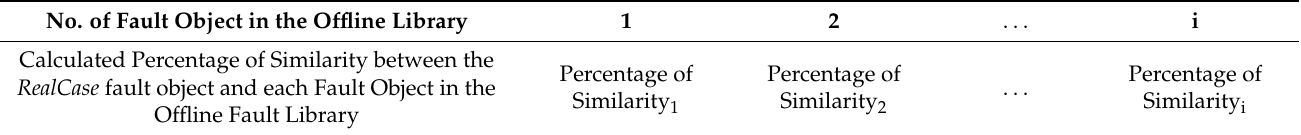
Table 11. Percentage_List for a RealCase